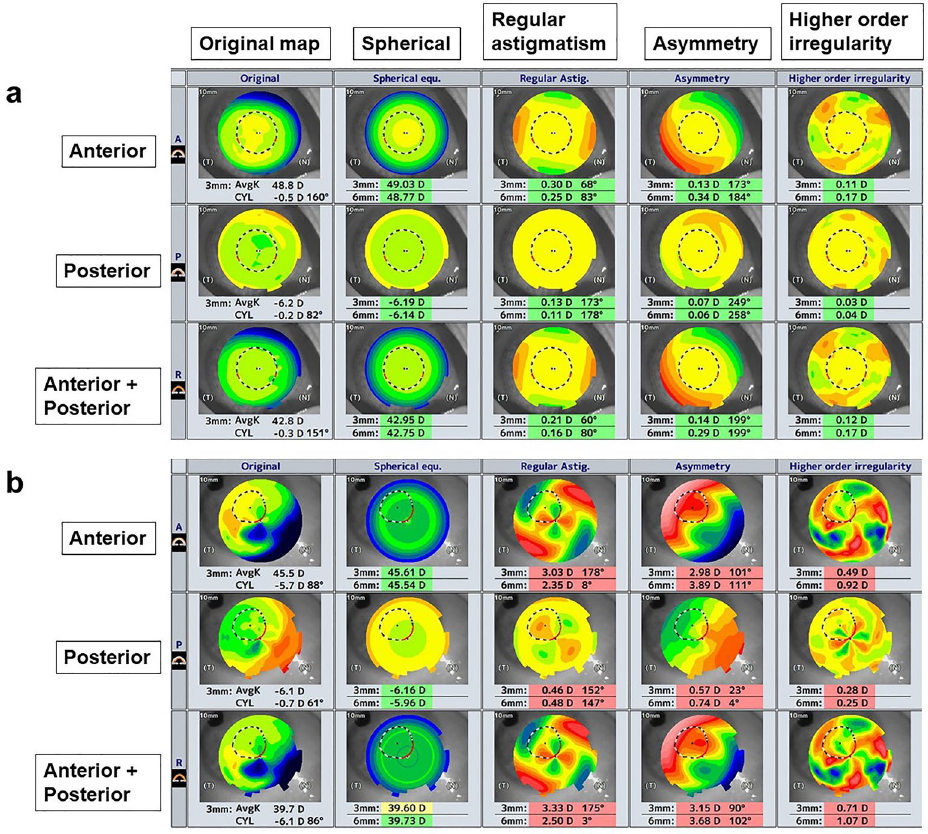
Figure 1. Representative Fourier maps taken with anterior segment optical coherence tomography in ( a ) control without corneal disease and ( b ) subject with bullous keratopathy (BK). The original color-coded map is separated into spherical component, regular astigmatism, asymmetry component and higher-order irregularity. Fourier indices from the central 3 mm and 6 mm zones are shown for the anterior, posterior, and anterior + posterior cornea. Central corneal thickness is 530 µm for the control and 724 µm for